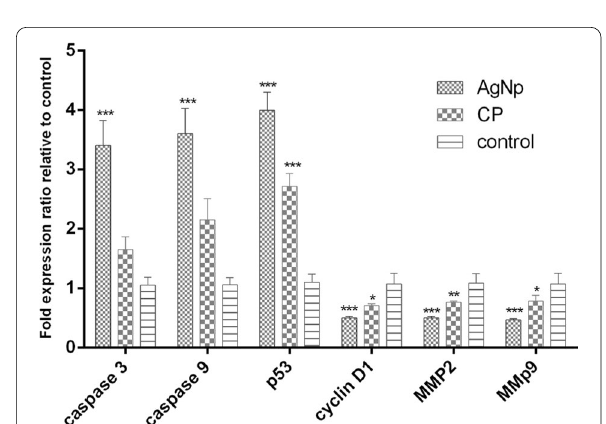
Fig. 6 Expression levels of caspase-3, caspase-9, MMP2, MMP9, p53 and cyclin D1 genes in the cells exposed to bio-synthesize AgNPs and cisplatin. (***P < 0.001 and **P <